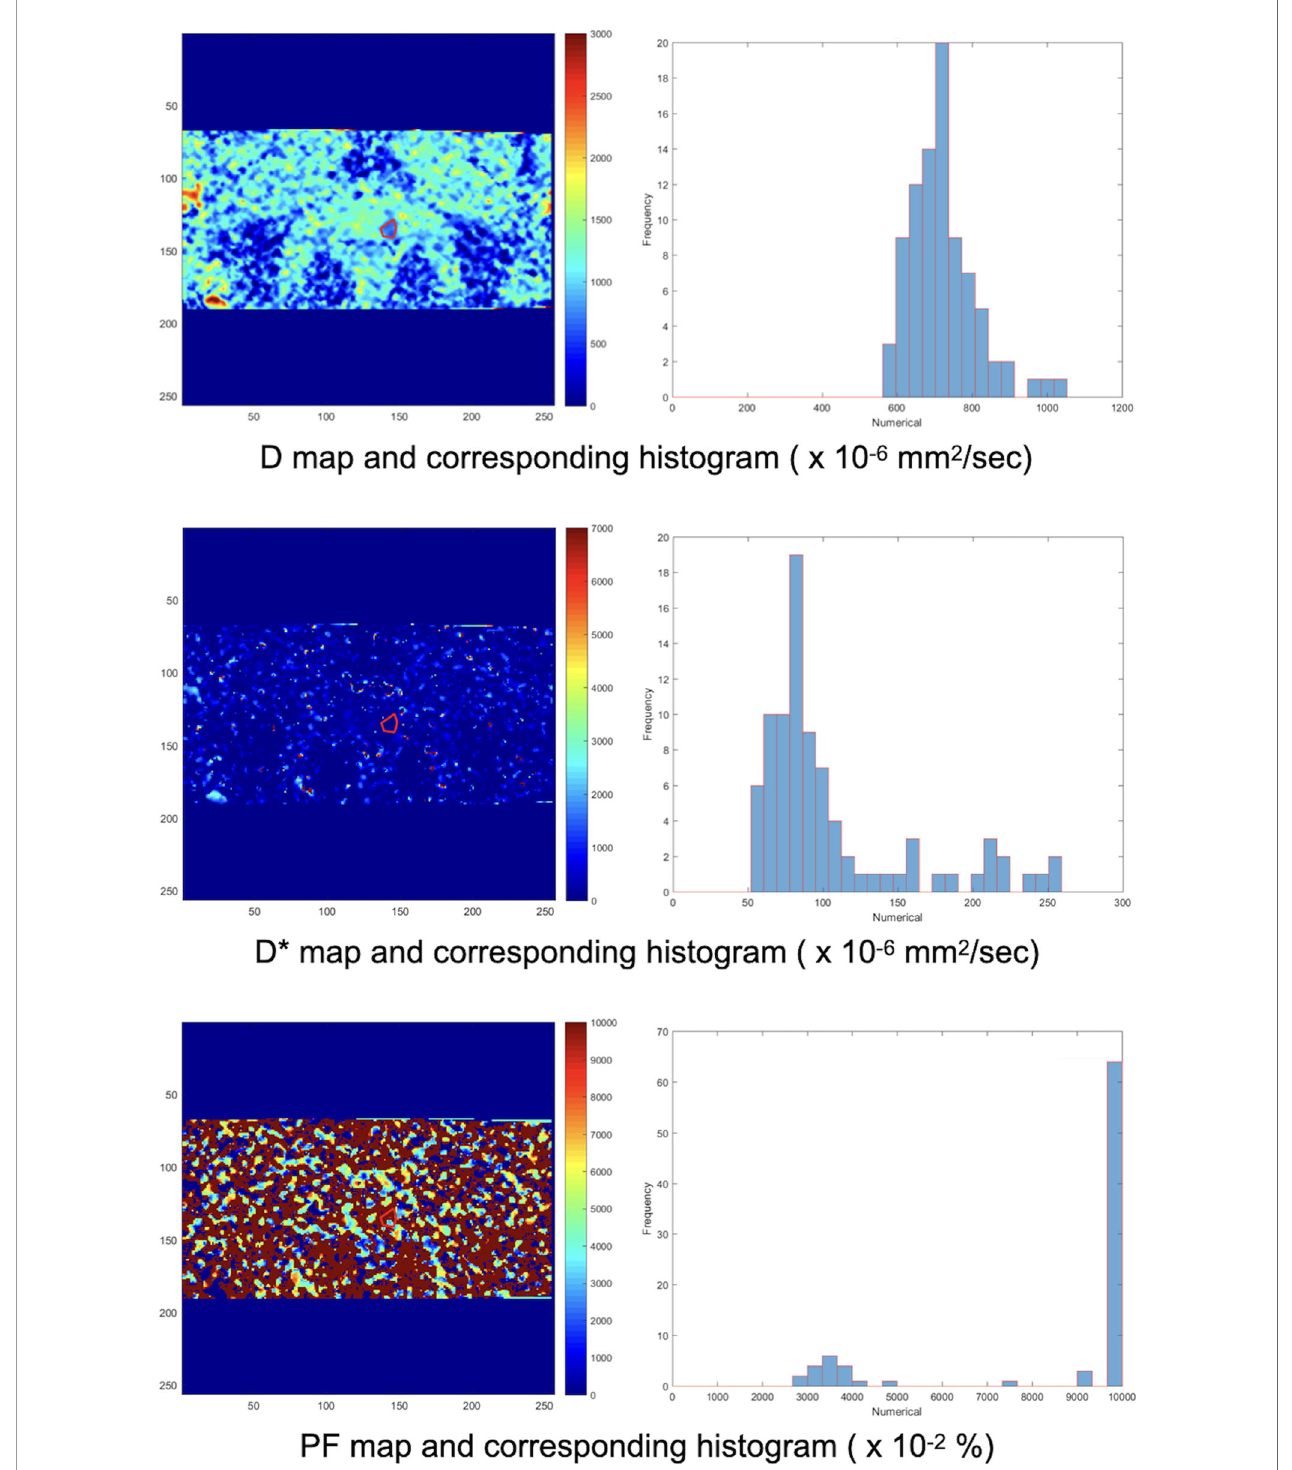
FIGURE 3 | Another ROI was delineated manually on the IVIM D map. The ROI on the D map was automatically copied to the D* and PF maps by our homemade software. Then, the corresponding histograms of the D, D*, and PF maps were obtained. The process was repeated for each DWI image and IVIM map containing the dominant tumor